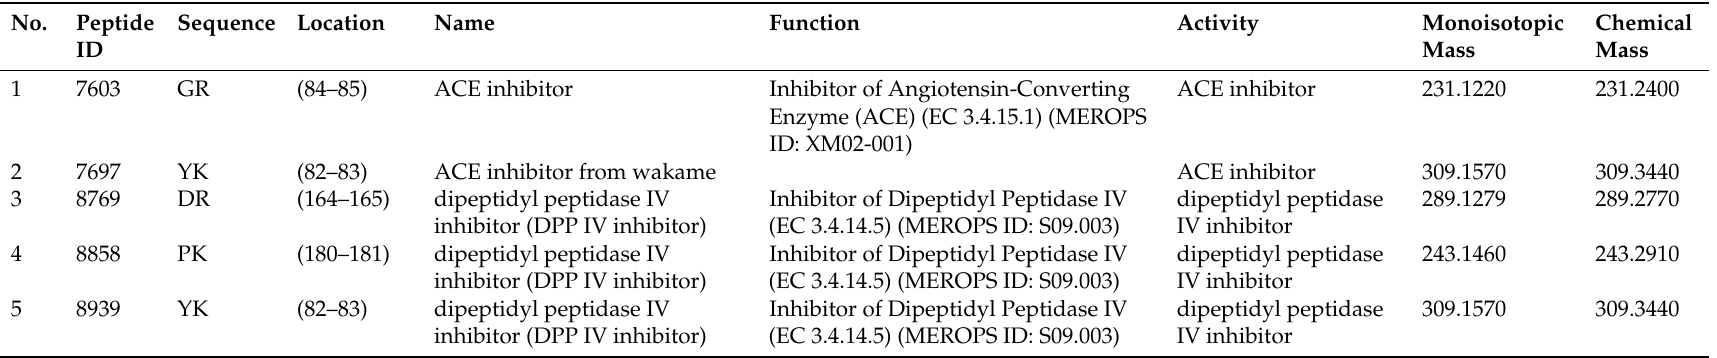
Table A19. Bioactive peptides from RubisCO of Halophila stipulacea . In silico enzymatic cleavage was carried out by using plasmin.